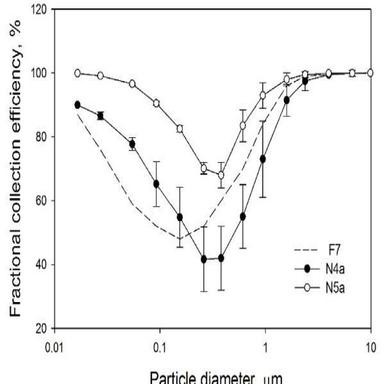
Effects of base mass (A) and packing density (B) on ePM1.